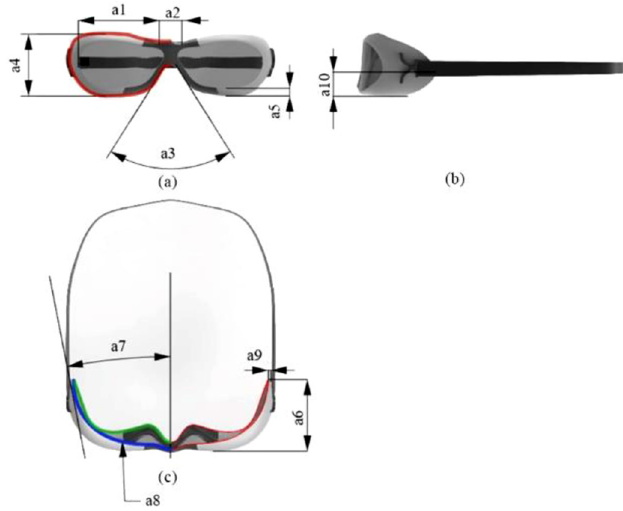
Fig. 4. Size parameters of swimming goggles (see Tab. 2). Table 2. Relationships between goggle size and head-feature points. Dimension parameter Dimension